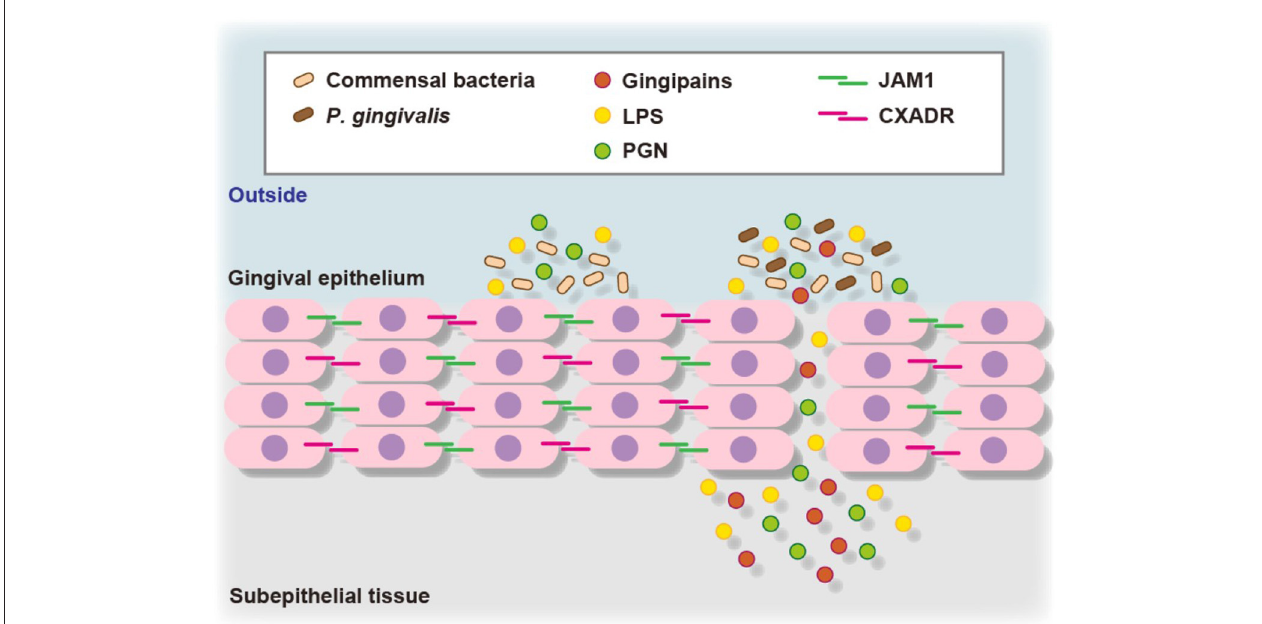
FIGURE 2 | Proposed model of transfer of bacterial virulence factors by P. gingivalis gingipains through gingival epithelium. P. gingivalis gingipains degrade JAM1 and CXADR, leading to increased permeability to gingipains, LPS, and PGN. Subsequently, gingipains become translocated to deeper epithelium for additional degradation of JAM1 and CXADR, thus allowing LPS and PGN to penetrate the gingival epithelium and reach subepithelial